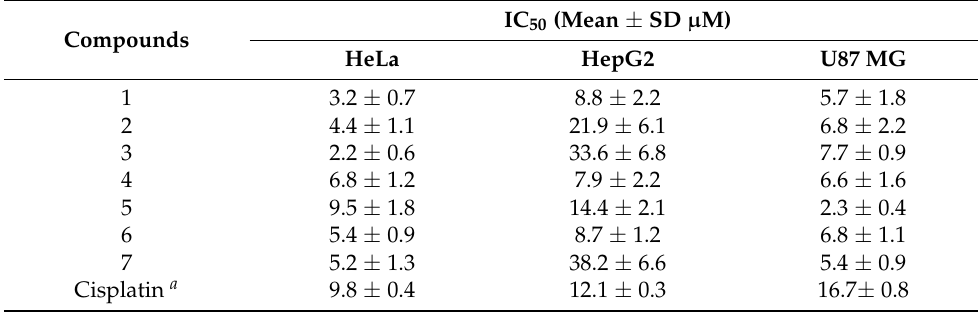
Table 2. Cytotoxic activities of compounds 1 – 7 against three human tumor cell lines (HeLa, HepG2 and U87 MG) (mean ± SD, n =